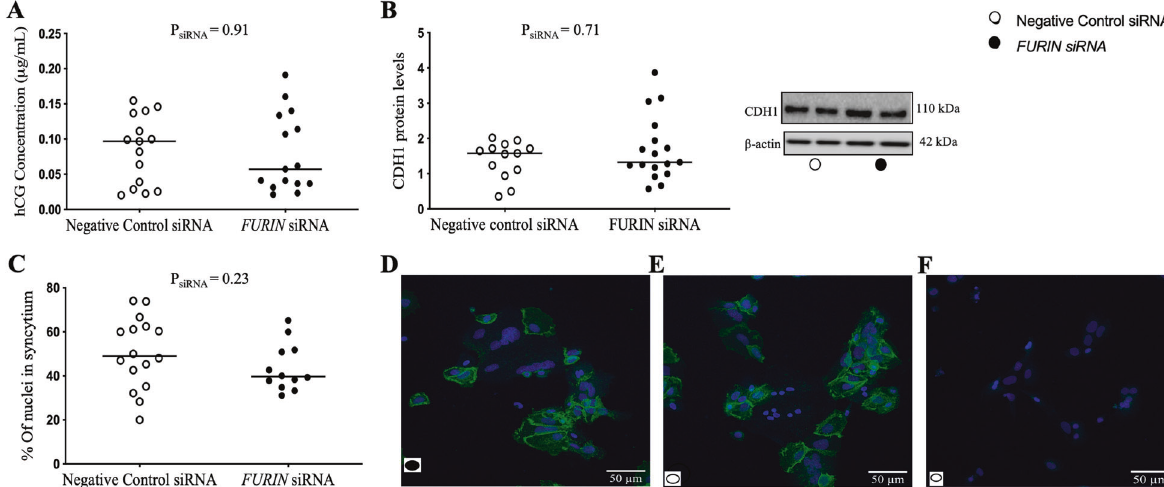
Fig. 1 FURIN siRNA did not affect syncytialisation of term human primary trophoblast cells. Trophoblasts were treated with FURIN siRNA and left to syncytialise for 72 h. FURIN siRNA had no effect on ( A ) hCG secretion, ( B ) E-cadherin (CDH1) protein levels or ( C ) the percent of nuclei in syncytia, compared with negative control siRNA. Representative images in ( D , E ) depict cells stained for CDH1 (green) and counterstained with DAPI (blue). F is a negative control image omitting the primary antibody, controlling for non-speci fi c secondary antibody binding. β -actin was used as a loading control in immunoblots. Data are presented as the median with effects of FURIN siRNA (P siRNA ) noted.